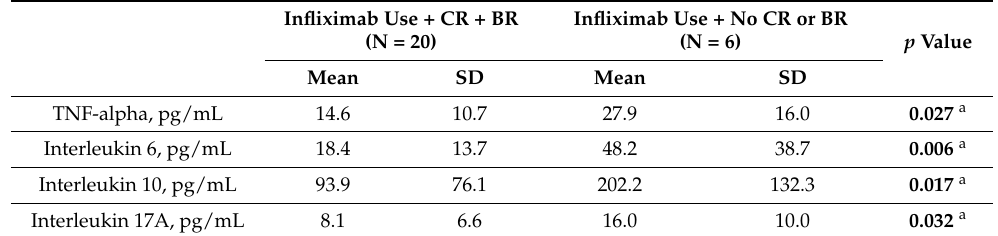
Table 3. Comparison of the initial cytokine profiles between patients with and without clinical remission and biochemical remission among patients treated with anti-TNF- α . ER; Endoscopic remission, SD; Standard deviation, TNF; Tumor necrosis factor, CR; Clinical remission, and BR; Biochemical